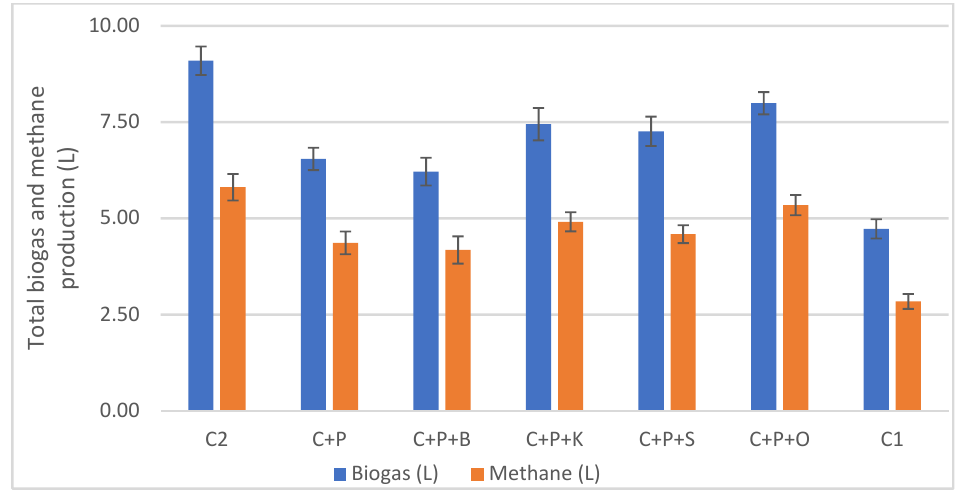
Figure 5. Biogas and methane volumes (in L) from the co-digestion tests. Being C2: Cow manure 2; C+P: Cow manure+Pig slurry; C+P+B: Cow manure+Pig slurry+Bird manure; C+P+K: Cow manure+Pig slurry+Kitchen waste; C+P+S: Cow manure+Pig slurry+Sewage sludge; C+P+O: Cow manure+Pig slurry+Oily lacteous waste; C1: Cow manure 1.